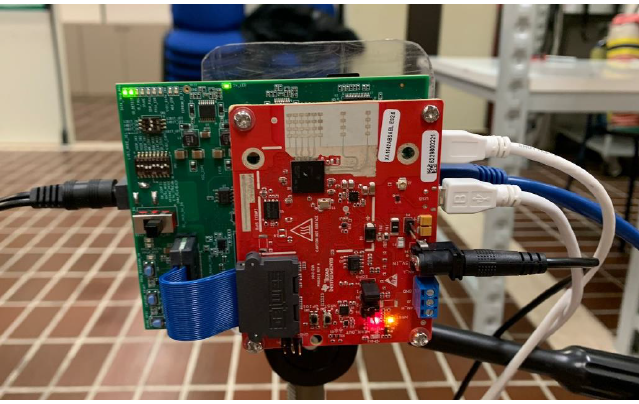
Figure 4. The Texas Instruments AWR1642 radar used in this